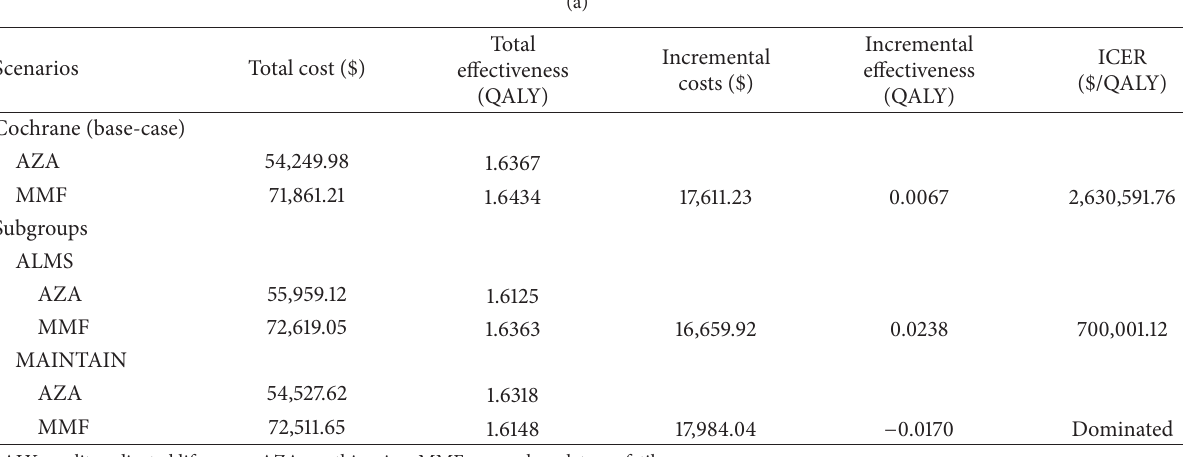
Table 3: (a) Costs, effectiveness, and incremental cost effectiveness ratios (ICER) of the base-case and individual clinical trials in three-year model. (b) Sensitivity analysis of three-year model using Cochrane